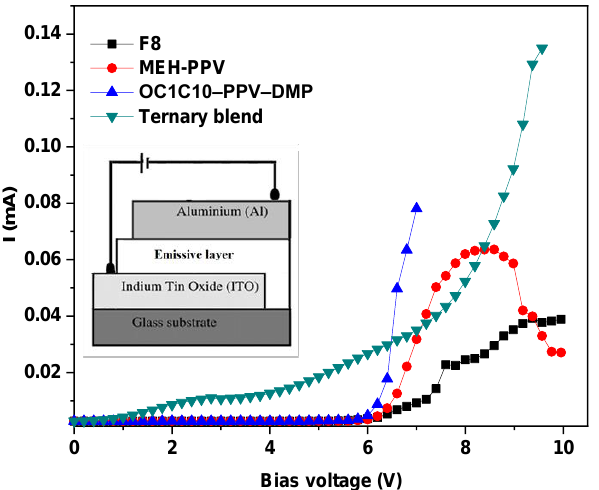
Figure 6. Current-voltage characteristics of OLEDs based on pristine F8, MEH-PPV, OC1C10-PPV- DMP, and their ternary hybrid. The inset is the schematic diagram of the OLED’s structure.